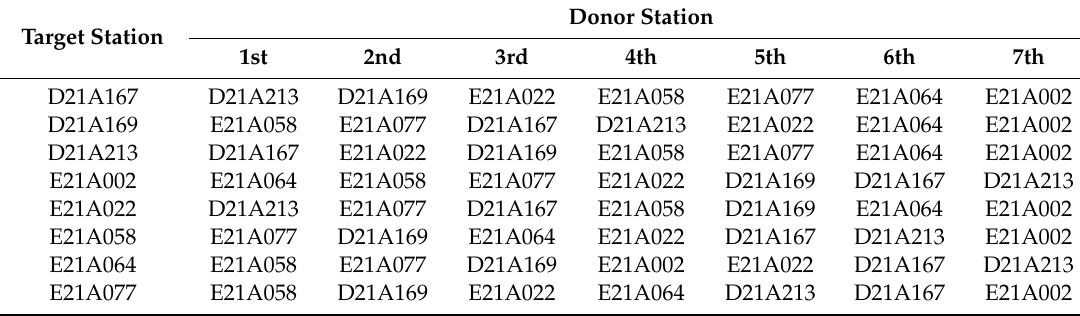
Table 6. Physically similar donor stations for each target station in the Middle Euphrates Basin.